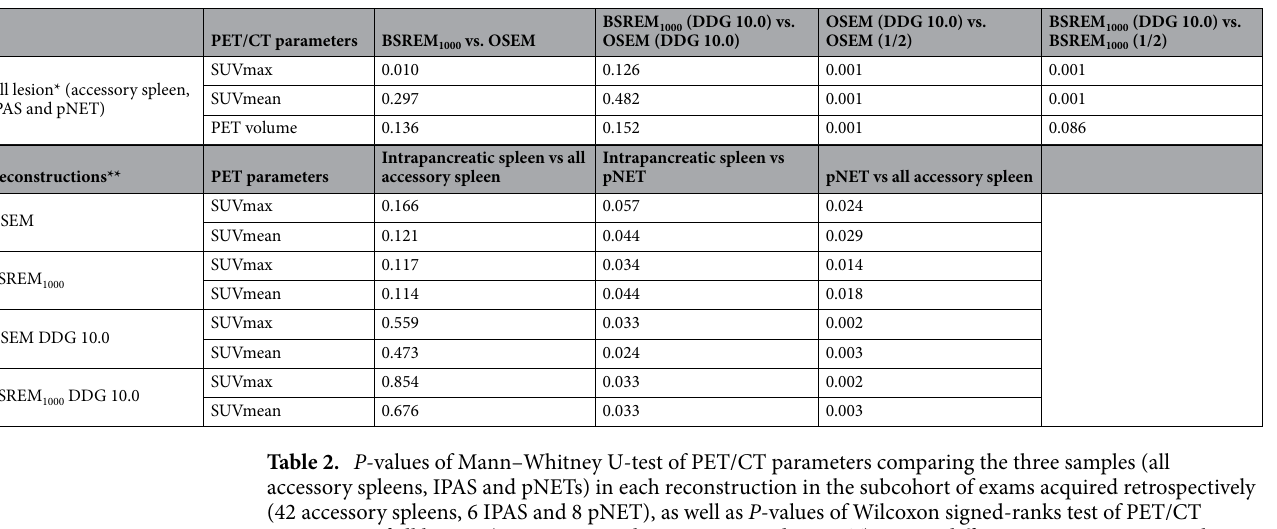
PET/CT parameters BSREM 1000 vs. OSEM